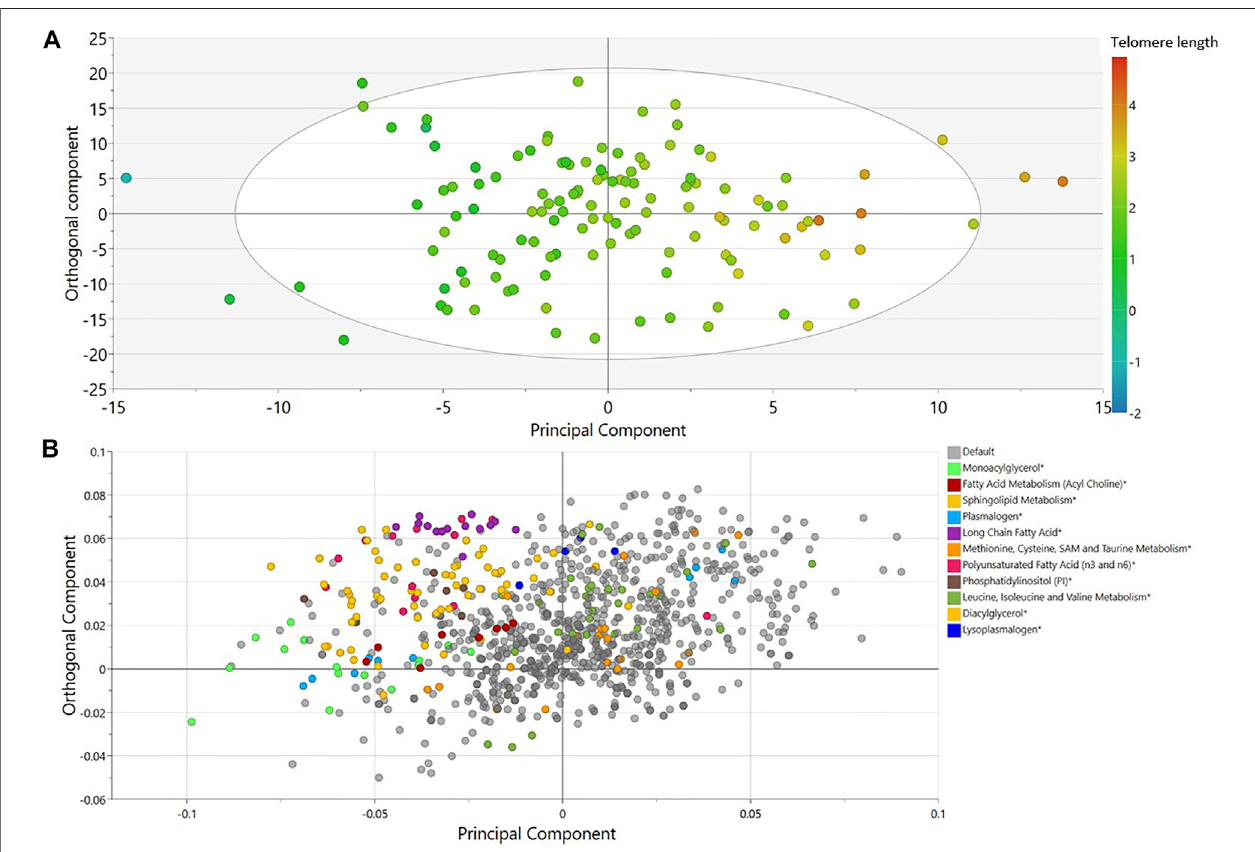
FIGURE 1 | OPLS model of metabolites associated with LTL in elite male soccer players. (A) Score plot showing the class-discriminatory component 1 ( x -axis) versusorthogonalcomponent( y -axis)forLTL. (B) ThecorrespondingloadingplotsshowingtopassociatedmetabolitesdifferentiatingshortfromlongLTL.Sub-pathway categories enriched in signi fi cant metabolites from regression analysis are shown in